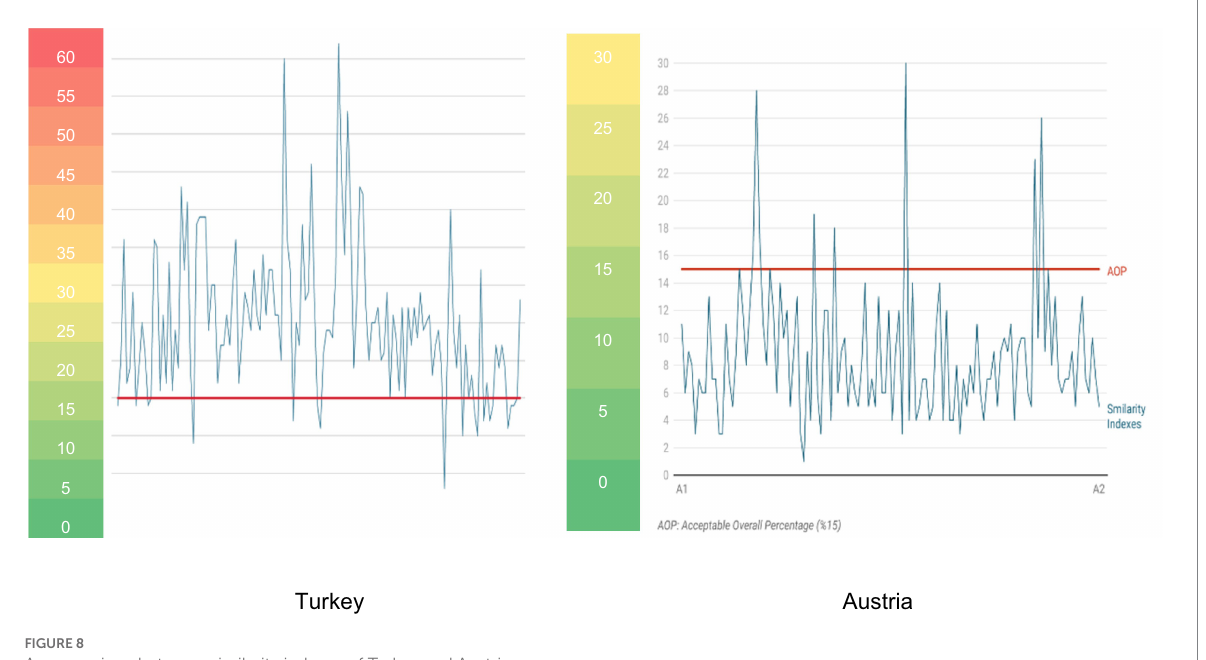
FIGURE 8 A comparison between similarity indexes of Turkey and Austria.